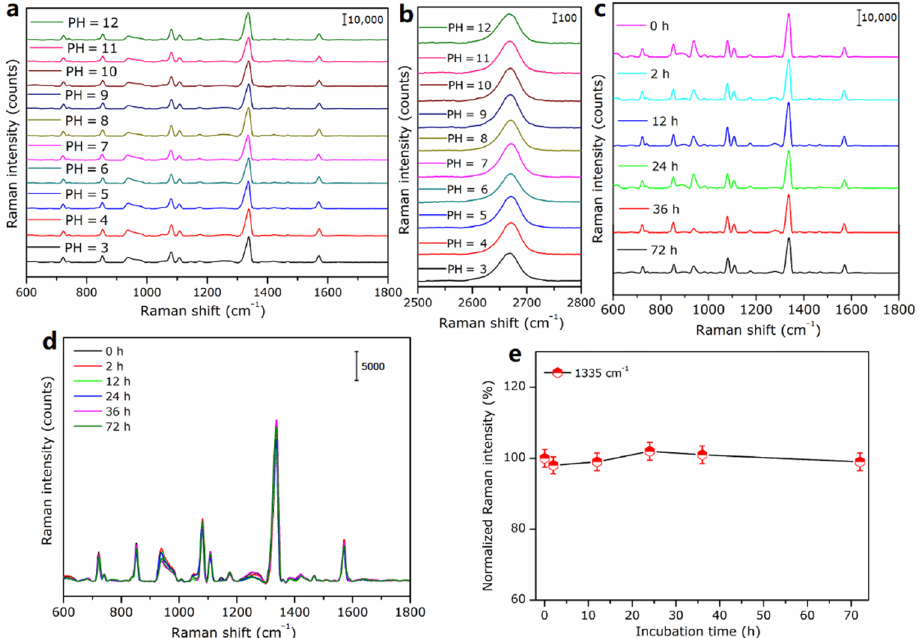
Figure 10. ( a ) SERS spectra of MS-GP-GERTs in aqueous solutions with different pH values; ( b ) 2D peak Raman curves of graphene in composite MS-GP-GERTs in aqueous solutions with different pH values; ( c ) SERS spectra of MS-GP-GERTs in 10% bovine serum albumin solution at different incubation times; ( d ) SERS spectra of MS-GP-GERTs in 10% glucose solution at different incubation times; ( e ) variation curve of normalized Raman intensity at 1335 cm − 1 during incubation of MS-GP- GERTs with normal saline.